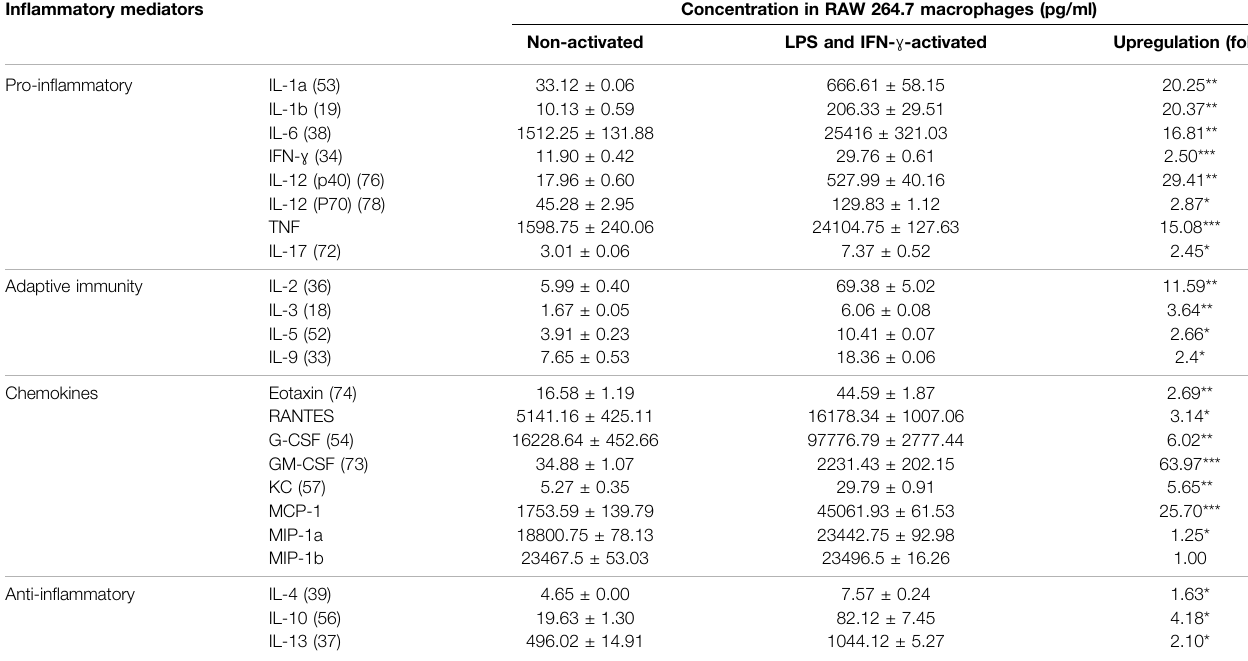
TABLE1| LPSandIFN- ɣ signi fi